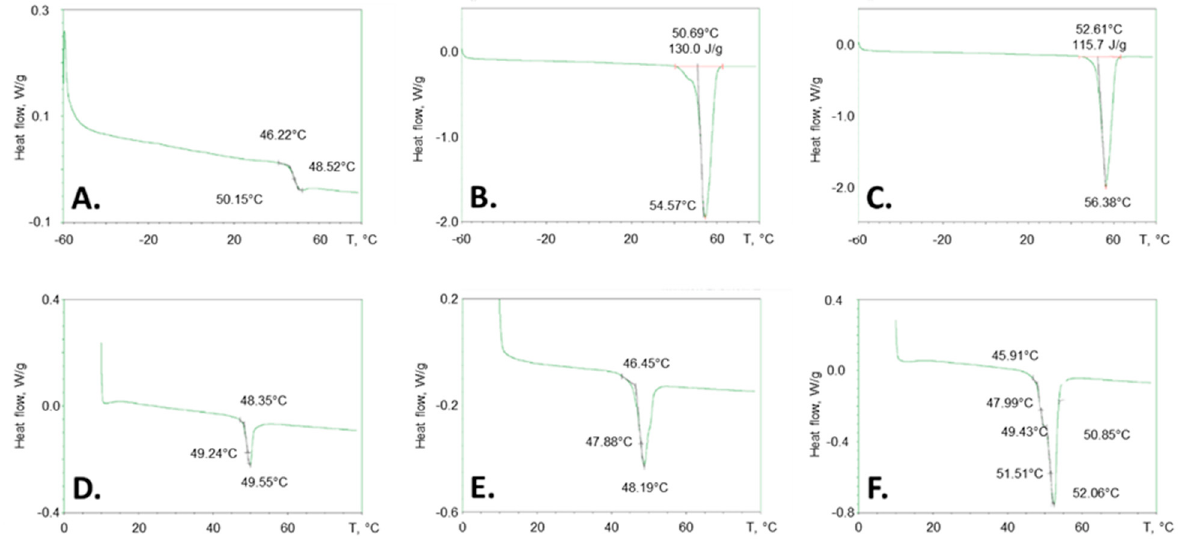
Figure 3. Representative DSC thermograms of PLGA powder ( A ); F68 powder ( B ); F127 powder ( C ); 20–100 ( D ), 20–90 ( E ), 20–70 ( F ) microparticles. Exotherm is directed upward.